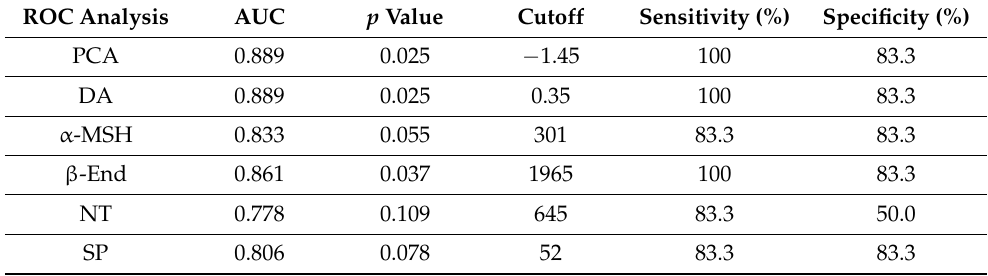
Table 3. Evaluation of the utility of four neuropeptides in predicting an autism-like disease in a PPA model of ASD using ROC analysis (PPA: n = 6, control: n = 6). PCA: first principal component in principal component analysis; DA: first principal component in discriminant